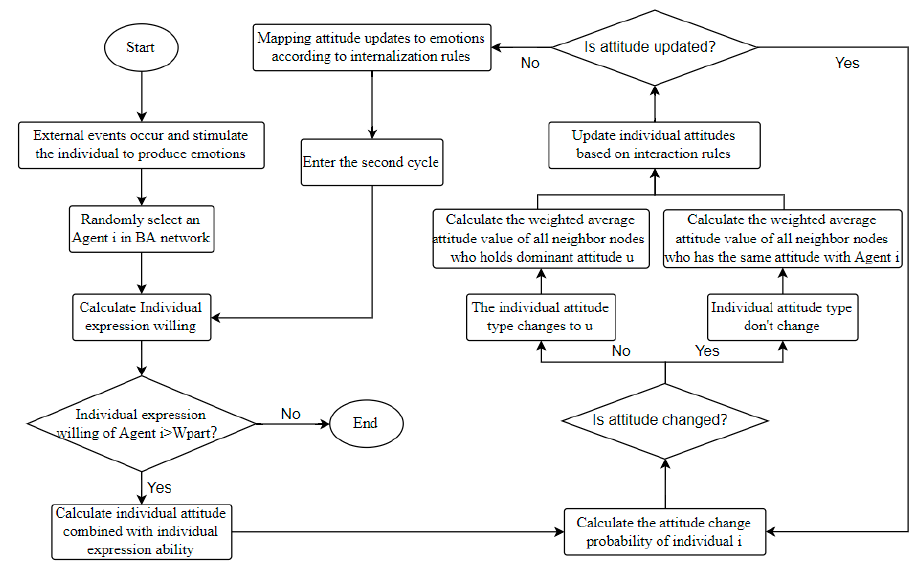
Figure 5. Simulation diagram based on multi-agent method proposed by Monte Carlo.